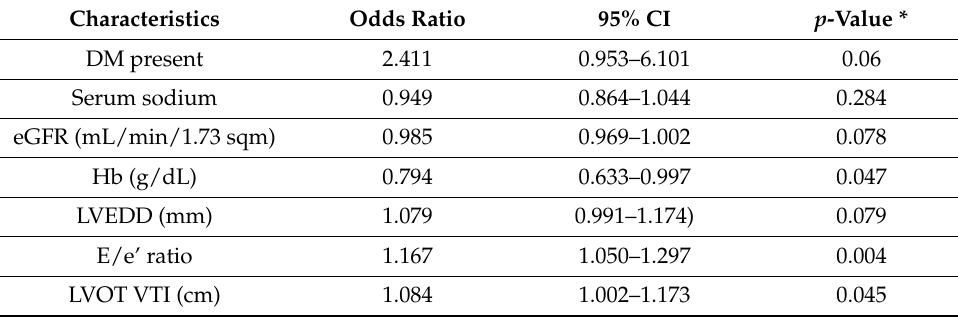
Table A3. Odds ratio (OR) for HFR at six